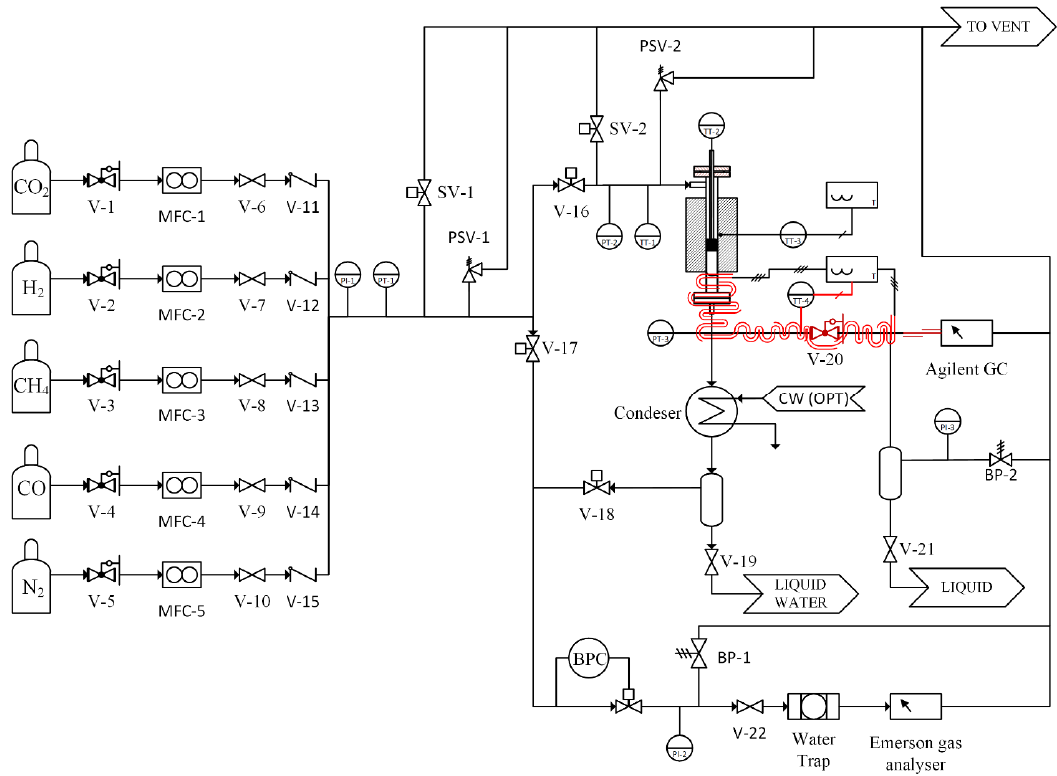
Figure 12. Pressurized catalytic testing setup. V-1 to V-5, V-20 pressure reduction valves; MFC-1 to MFC-5 mass flow controllers; V-6 to V-10, V19, V-21, V-22 manual ball valves: V-11 to V-15 check valves; V-16 to V-18, SV-1 and SV-2 actuated ball valves; PSV-1 and PSV-2 pressure safety valves; BP-1 and BP-2 manul back pressure control valve; BPC back pressure controller. Table 8. Catalyst